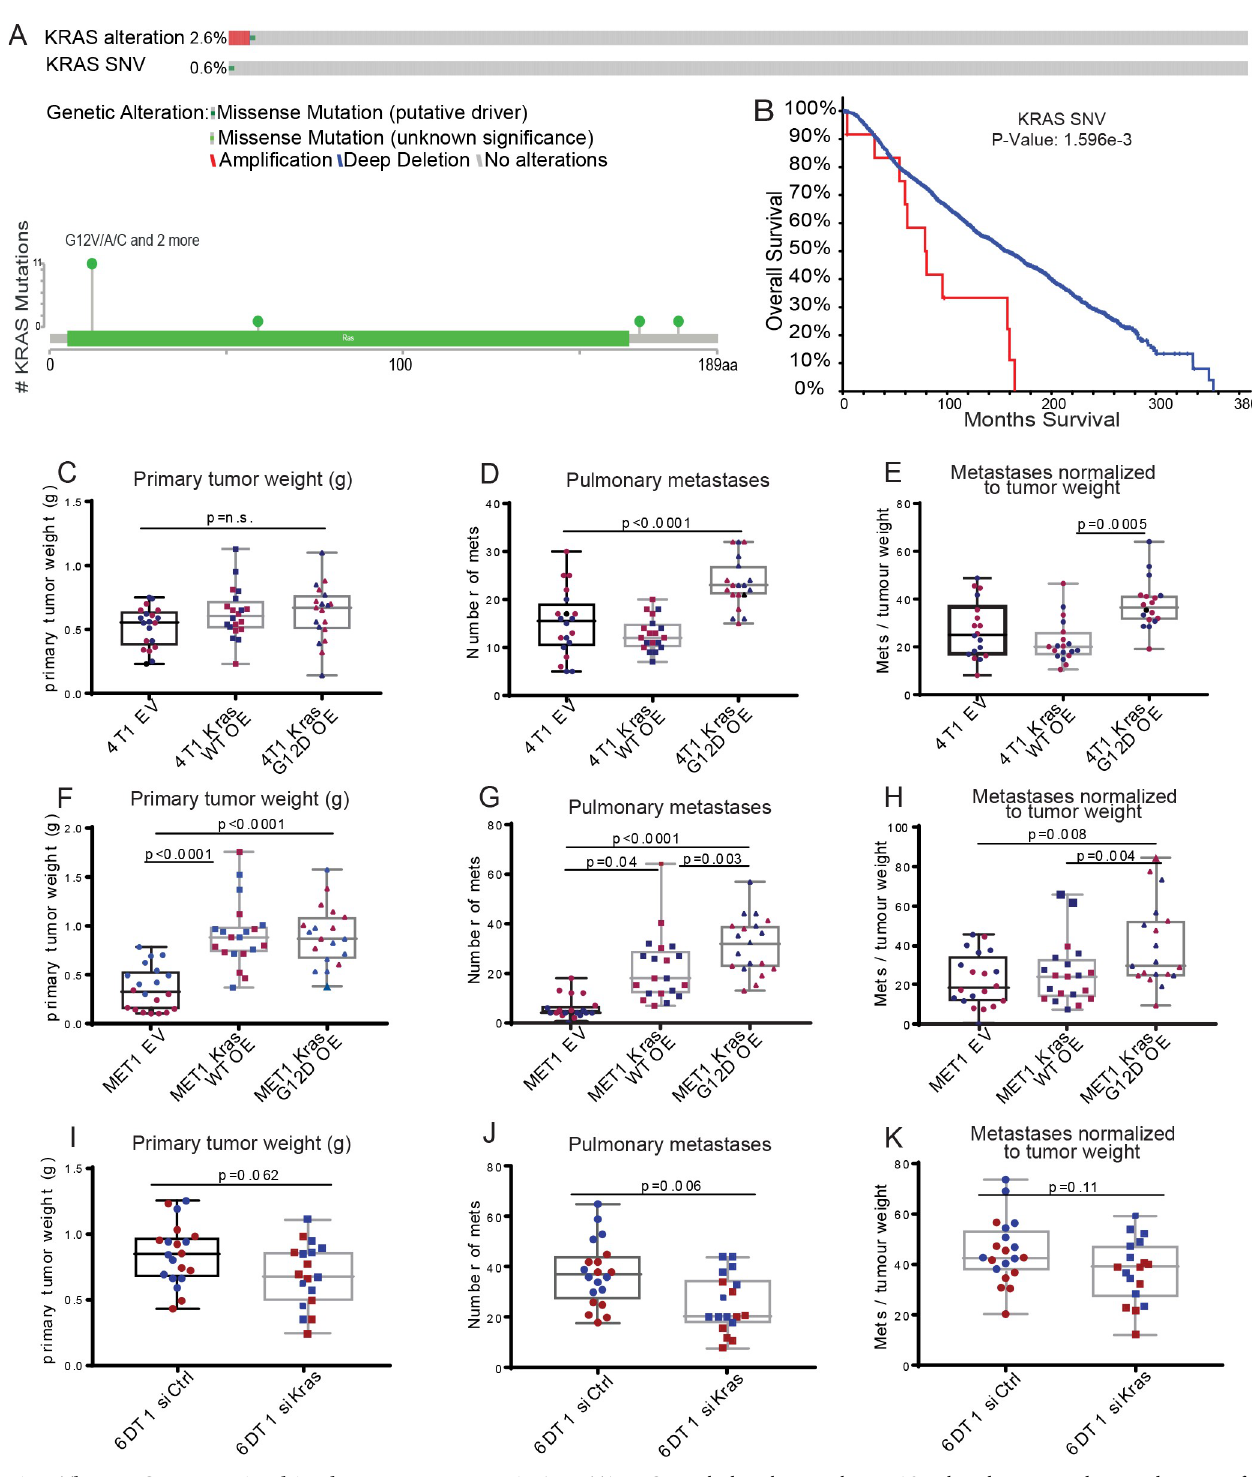
Fig 7. The Kras G12D mutation drives breast cancer metastasis. A. METABRIC sample data showing that KRAS is altered in 2.6% and mutated in 0.6% of primary tumors from breast cancer patients. B. Kaplan-Meier analysis of patients with SNVs (red) in KRAS vs (wildtype) WT (blue). C-K. Primary tumor weights, numbers of metastases, and metastases normalized to primary tumor weight from orthotopic injection of 4T1 cells transduced with empty vector (EV), Kras WT, or Kras G12D ( C-E ), MET1 cells transduced with EV, Kras WT, or Kras G12D ( F-H ), or 6DT1 cells transfected with siControl or si Kras ( I-K ). Each assay was performed twice with 10 mice per group (red and blue points), box whiskers represent min and max points, box boundaries represent the 25th to 75th percentiles, and the horizontal line within the box represents the median. p < 0.05 = significant.